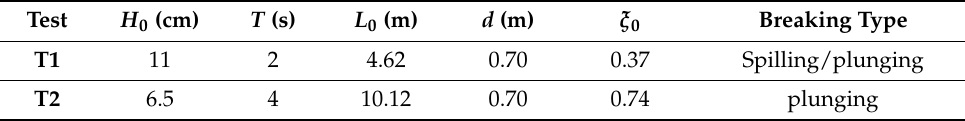
Table 1. Experimental parameters of the analysed regular